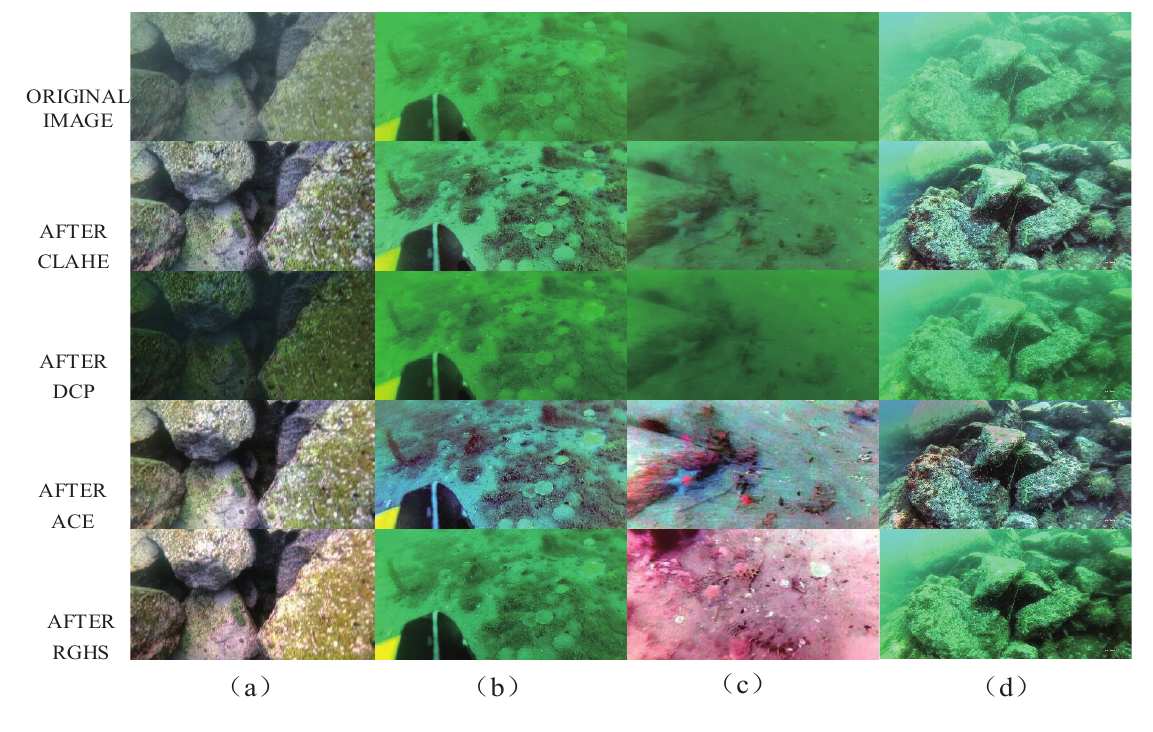
Figure 7. Visual effects of different image processing algorithms. ( a – d ) represent underwater images from four typical